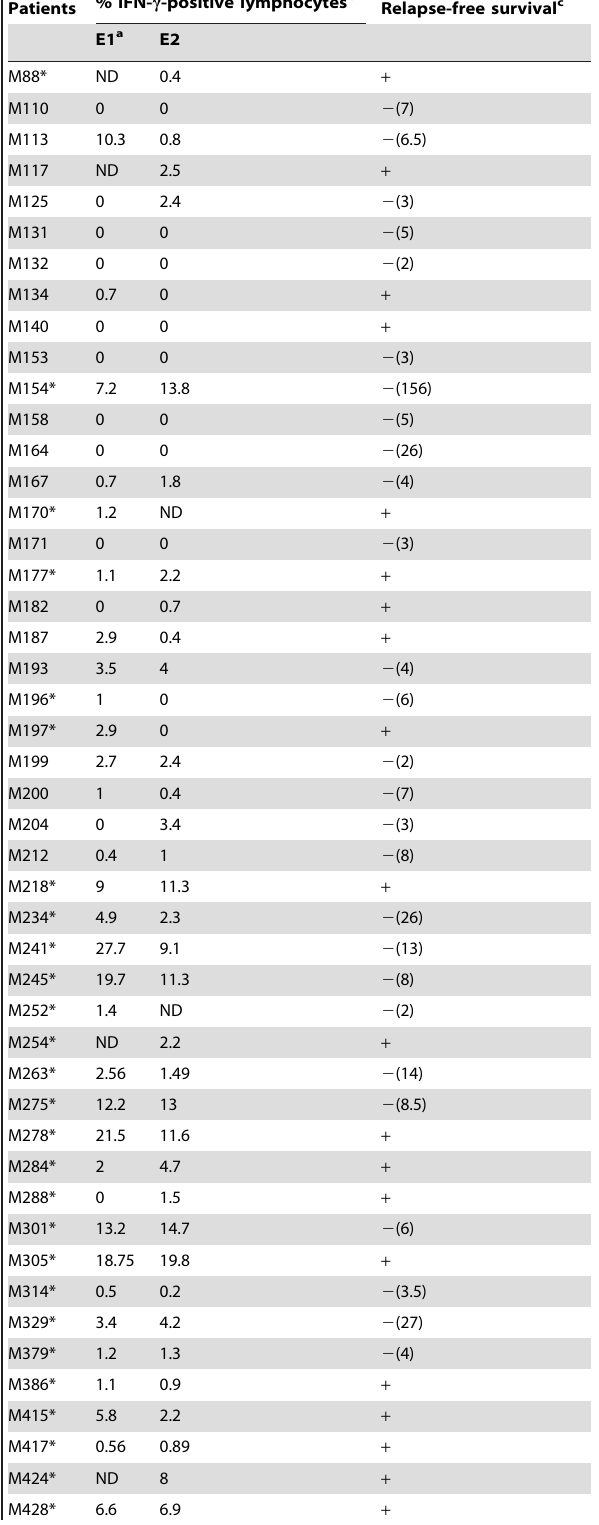
Patients % IFN- c -positive lymphocytes